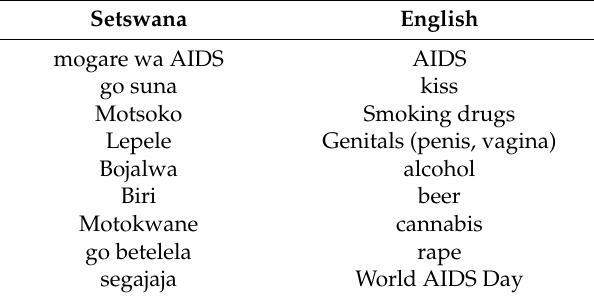
Table 1. Key filter terms.